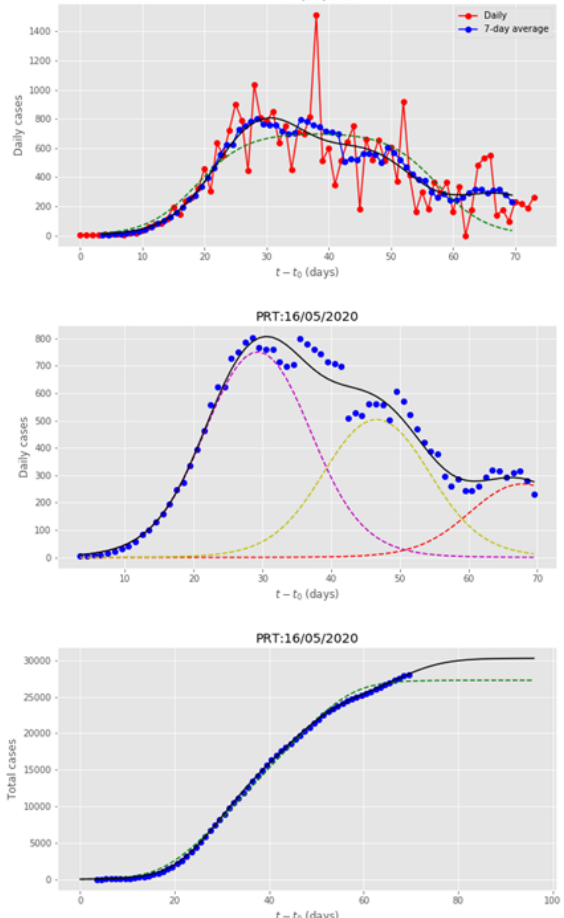
Figure 5. Results for ITA and PRT, obtained by fitting the multiple-wave forced-susceptible-infectious-removed (FSIR) model with data up to May 16, 2020. Top row: Red dots are the daily data reported by the European Centre for Disease Prevention and Control. The blue dots are 7-day running averages of the daily data. The green dashed line is the fit by the single-wave FSIR model. The black solid line is the 4-wave fit by the multiple-wave FSIR model. Middle row: Decomposition of the 7-day running average data (blue dots) in 4 waves for ITA and 3 waves for PRT. The black line represents the superposition of the multiple waves. The fit is in excellent agreement with the actual data. Bottom row: Blue dots are cumulative daily data (7-day running averages). The black line is the fit by the multiple-wave FSIR model, and it is essentially indistinguishable from the actual data. The green dashed line is the fit of the single-wave FSIR model, which clearly underfits the actual data. ITA: Italy; PRT: